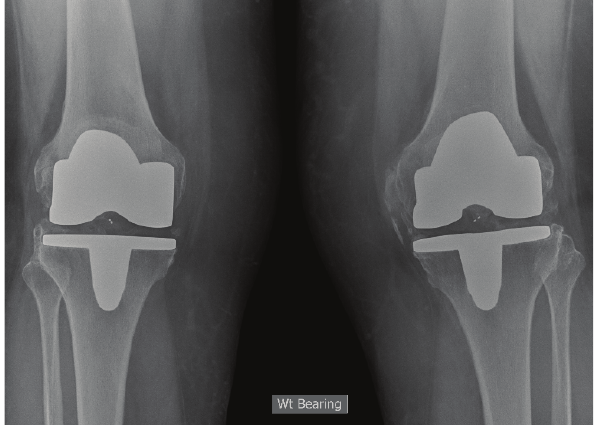
Figure 3: Postoperative radiographs of the total knee replacement at 8 months showing the severe heterotopic